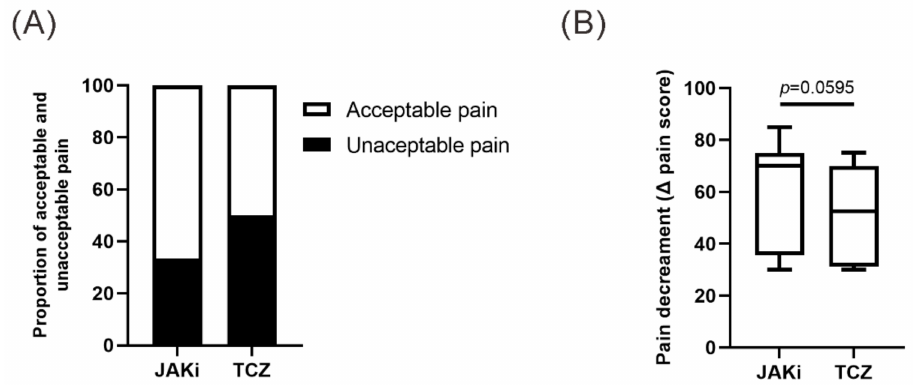
Figure 1. ( A ) Proportion of acceptable pain and unacceptable pain and ( B ) comparison of pain decrement in JAKi-treated and TCZ-treated patients. A Fisher’s exact test was used for between-group comparison of the proportion of acceptable pain. Data in ( B ) are presented as box-plot diagrams, with the box encompassing the 25th percentile (lower bar) to the 75th percentile (upper bar). The horizontal line within the box indicates median value respectively for each group. The p -value was determined by